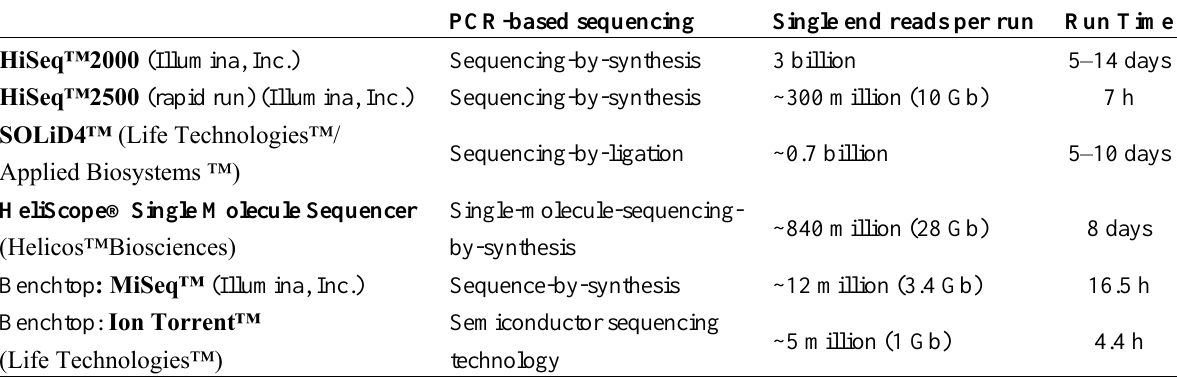
Table 3. NGS Platforms suitable for NIPT (adapted from